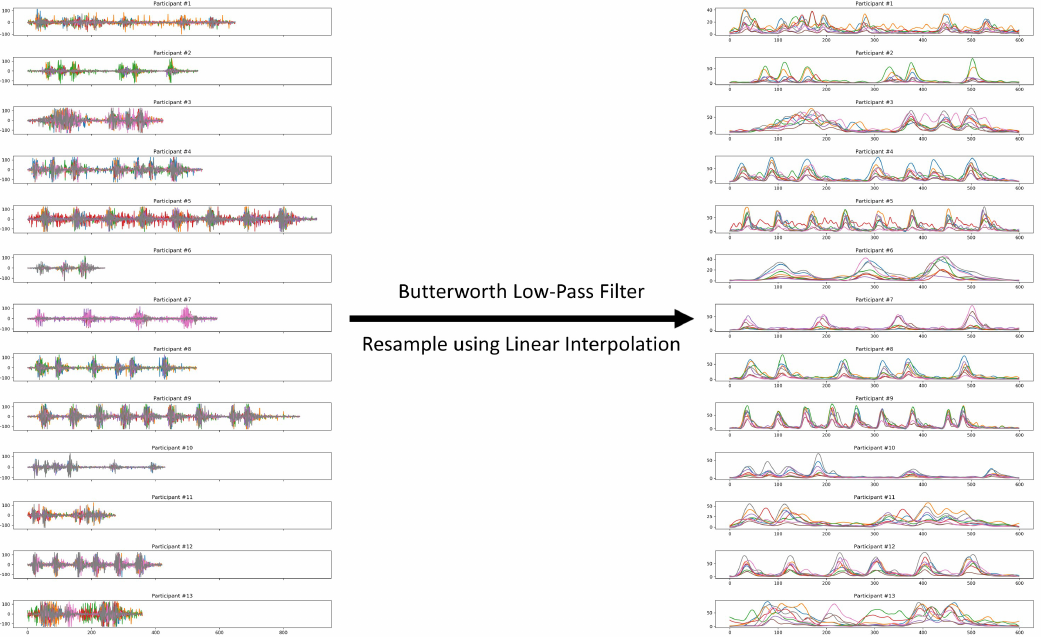
Figure 4. Samples of the raw signal ( left ) and processed signal ( right ) after being filtered using Butterworth low-pass filter and then resampled using linear